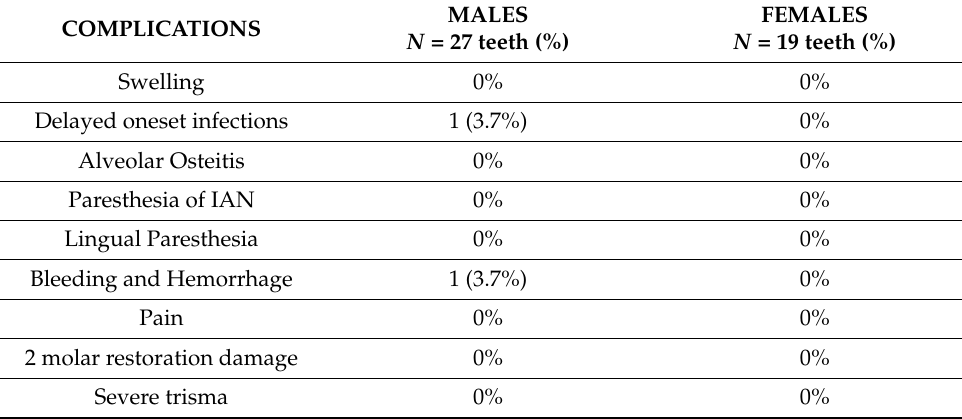
Table 1. Complications according to patients’